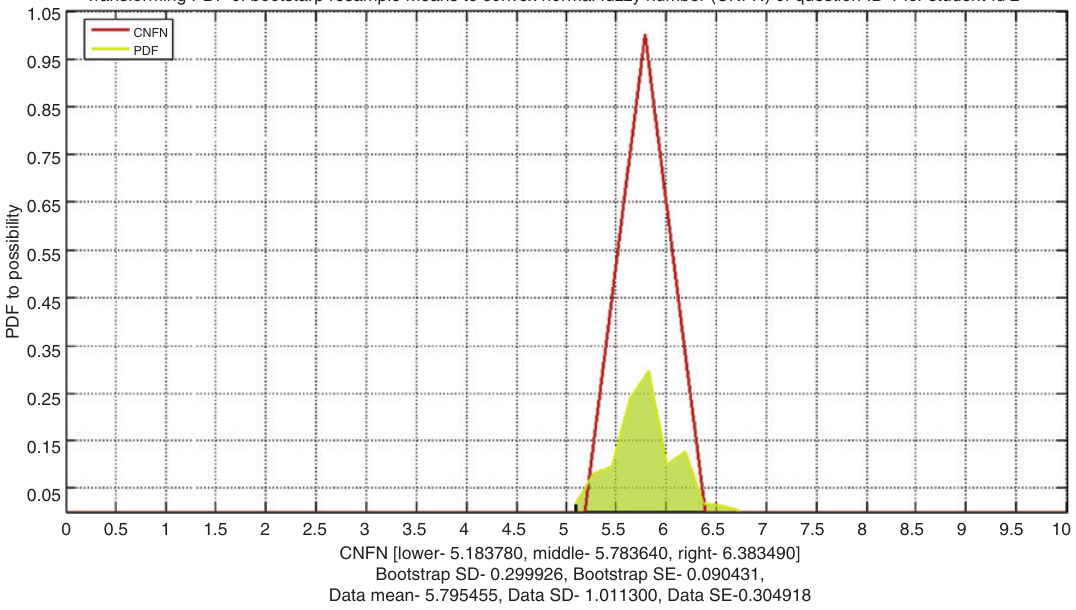
) to Possibility Distribution, i.e. CNFN “A” for Question 1 of Student ID-02 after 1000 Iterations Figure 2: Transformation of pdf p ( x i of Bootstrap